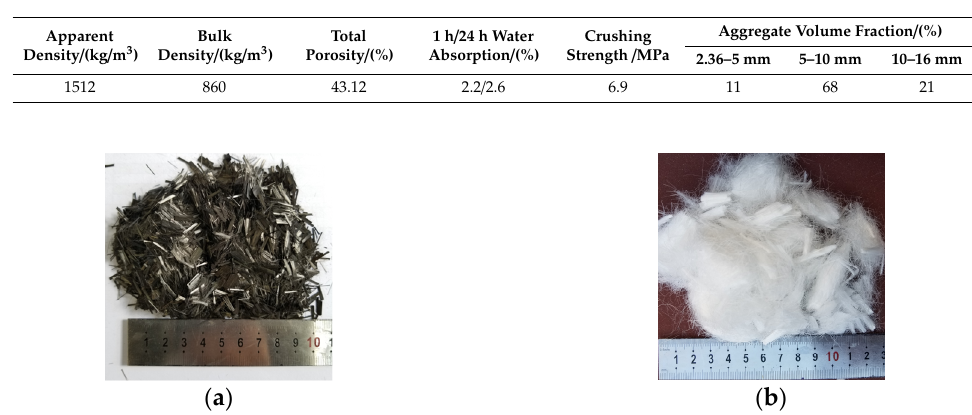
Figure 2. Fiber features: ( a ) carbon fiber, ( b ) polypropylene fiber.